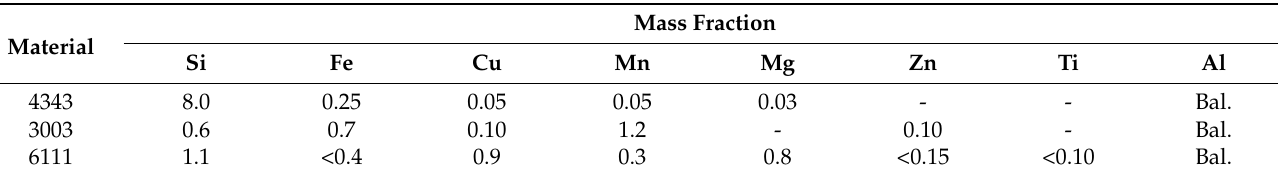
Table 1. Chemical composition of 4343/3003/6111/3003 Al clad sheet